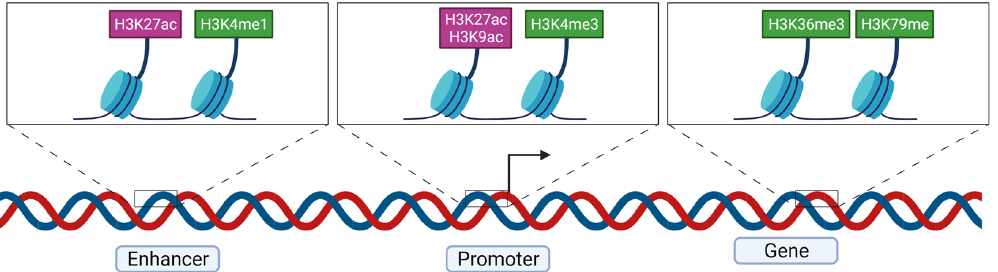
Figure 5. Major histone marks found at active enhancers, promoters and gene bodies. The arrow represents the transcription start site. H3K27ac is found both at active enhancers and promoters. H3K4me1 is enriched in enhancer regions whereas H3K4me3 is found mostly at promoters. Active gene regions are enriched in H3K36me3, H3K79me2 and